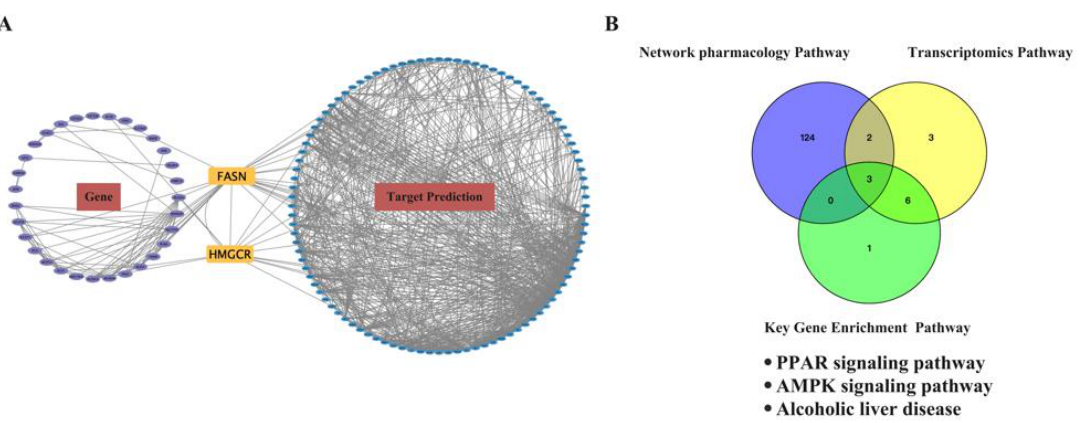
Figure 10. Influence of antioxidant effect of EEP on hyperthyroidism-induced oxidative stress on transcriptomics profiles and network pharmacology analysis. ( A ) Gene Target-Prediction Target network. The purple ellipses represent the key targets of antioxidant gene against hyperthyroidism from transcriptomics, the blue ellipses represent the key targets of antioxidant protein targets against hyperthyroidism from network pharmacology, and the orange rectangle represent common gene targets. ( B ) Common pathways of transcriptomics and network pharmacology analysis. Common pathways between network pharmacology and transcriptomics analysis were selected as potential mechanism pathways for EEP antioxidative effect against hy- perthyroidism by the Venn tool in Figure 10B. Three pathways were selected, namely the PPAR signaling pathway, the AMPK signaling pathway, and alcoholic liver disease. Considering that alcoholic liver disease is too broad, the PPAR signaling pathway and